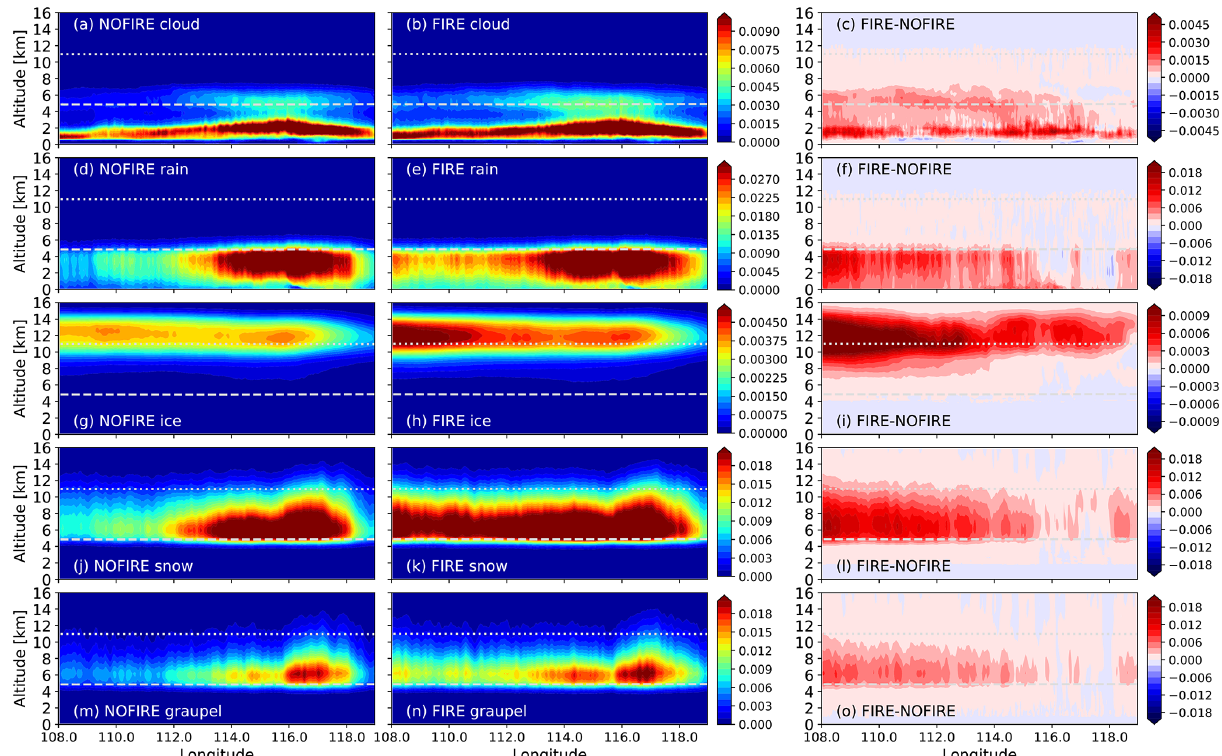
Figure 11. Monthly and meridional mean mass concentrations (gm − 3 ) of (a, b) liquid cloud, (d, e) rain, (g, h) ice, (j, k) snow, and (m, n) graupel in (a, d, g, j, m) NOFIRE and (b, e, h, k, n) FIRE over Region 3. These are averages inside grid boxes wherein each hydrometeor mass > 0. Respective differences (FIRE − NOFIRE) are shown in the rightmost column. The dashed and dotted lines are temporally and meridionally averaged 0 and − 40 ◦ C isotherms, respectively. See Fig. A1 for equivalent difference figures for Regions 1 and 2.